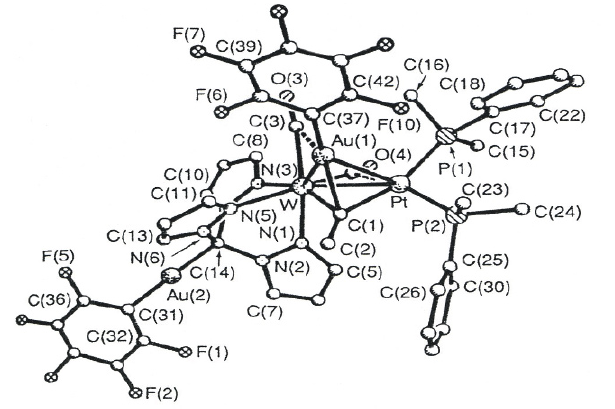
Figure 16. Structure of [(PMe